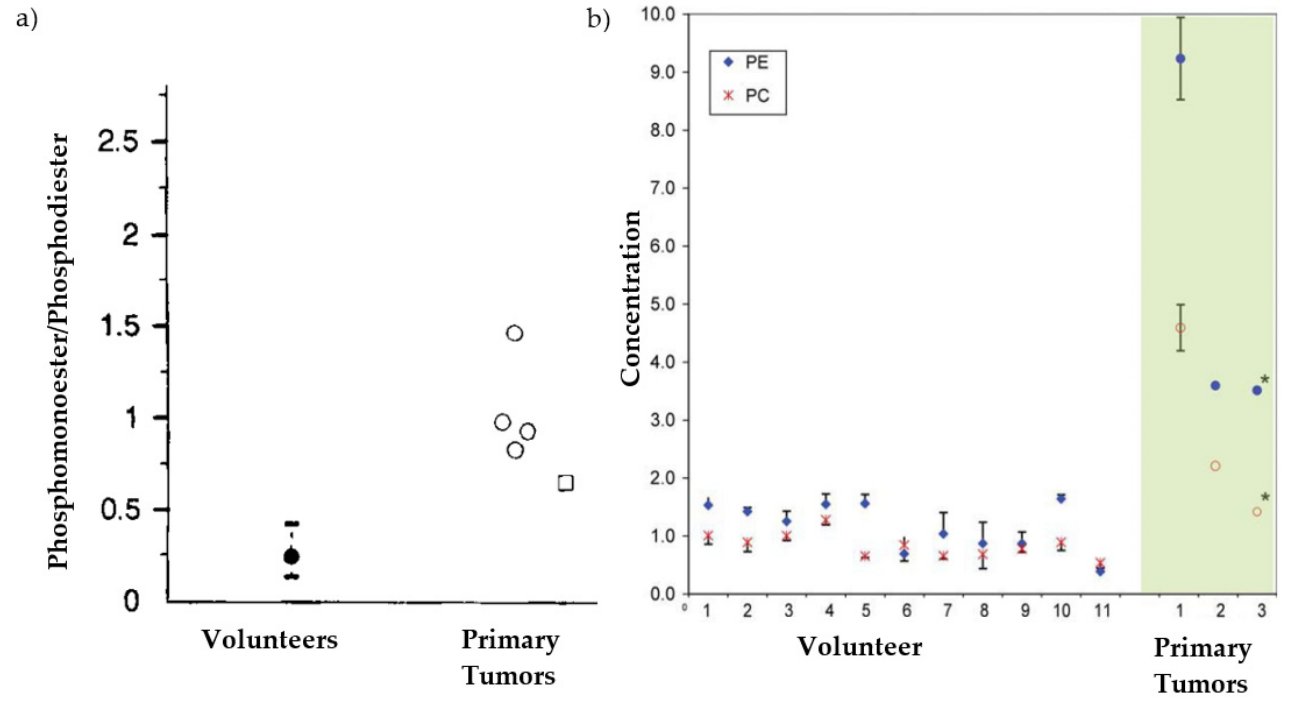
Figure 4. Non-overlapping measures for patients versus healthy tissue in vivo. ( a ) Data from primary liver tumors demonstrates that the phosphomonoester (e.g., phosphocholine (PC) and phosphoethanolamine (PE)) to phosphodiester ratio of the primary tumor spectra did not overlap with the ratios from any of the volunteers ( n = 28; mean +/ − 2 standard deviations); from Cox et al. [33]. Open circles represent hepatocellular carcinomas, while open squares indicate other primary liver tumors. Black circle indicates spectra from a healthy volunteer. ( b ) Similarly, the phosphomonoester (PE and PC) concentrations were non-overlapping with those of the healthy volunteers (7T, breast cancer; from Wijnen et al. [43]). Green shading delineates data points from tumors, and asterisks indicate datapoints collected using 1D chemical shift imaging instead of 2D.